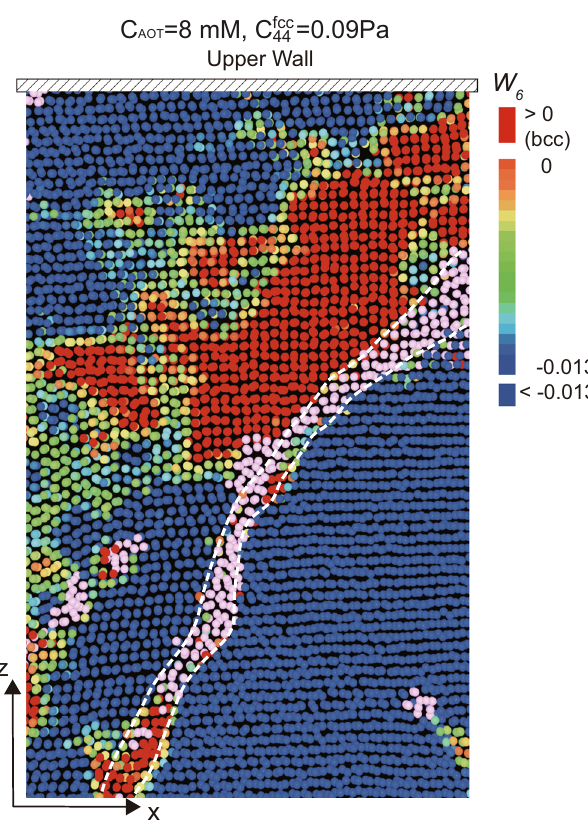
Fig. 10 Rare realisation of wall-assisted growth for the strong-driving force. The x – z image suggests that wall-assisted growth is not favoured at the strong-driving force. Usually, the grain boundary ends at the wall, and the premelted grain boundary has a more predominant effect than the smooth wall. Accordingly, wall-assisted growth is rarely observed under a strong-driving